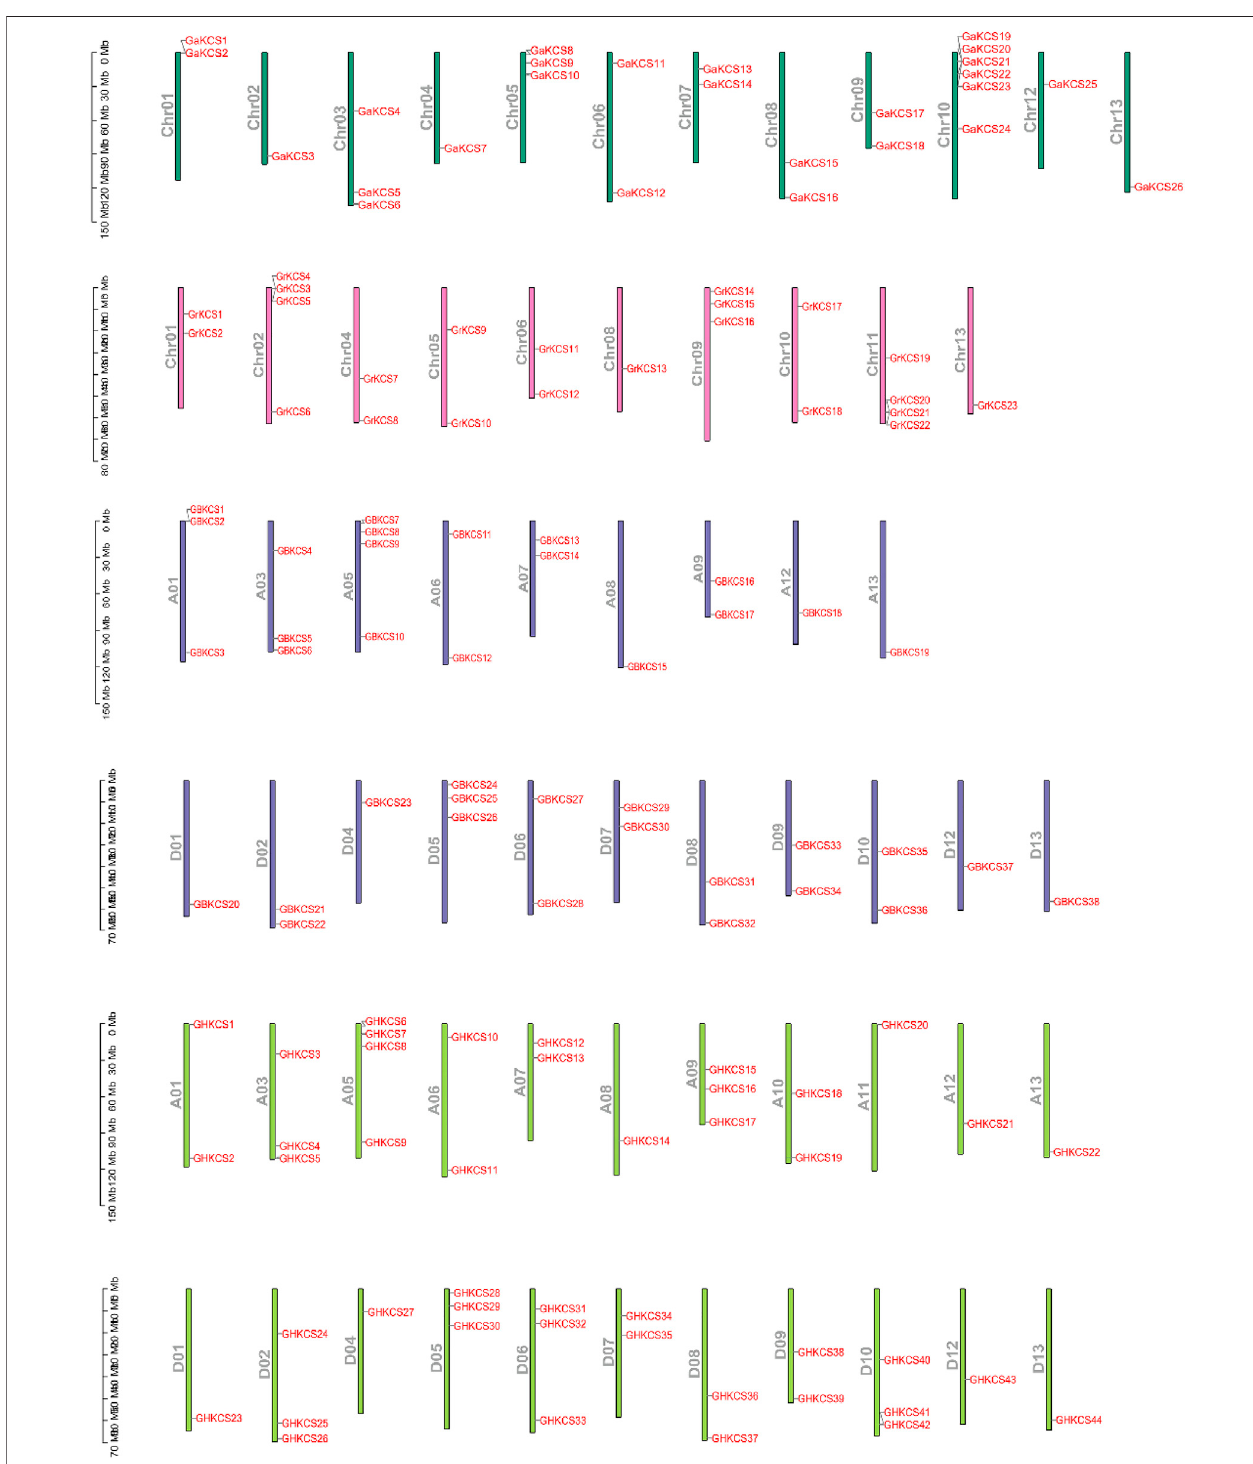
FIGURE 3 | Chromosomal location of KCS genes in four cotton species.